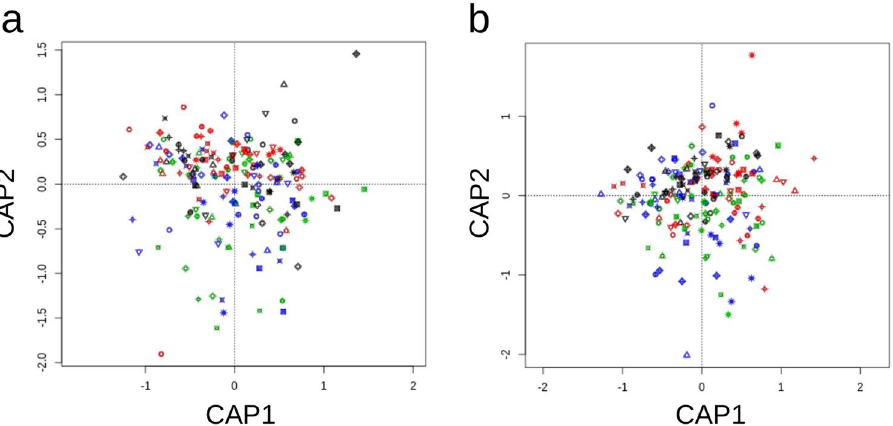
Figure 3. Impact of within-domestication group genotypic variation on bacterial and fungal communities composition. Constrained analyses of principal coordinates of bacterial ( a ) and fungal ( b ) communities. Black, red, green and blue dots correspond to T. turgidum spp. dicoccoides , T. turgidum spp. dicoccum , T. turgidum spp. durum landraces and T. turgidum spp. durum elite cultivars, respectively. Genotypes are encoded with different symbols within each domestication